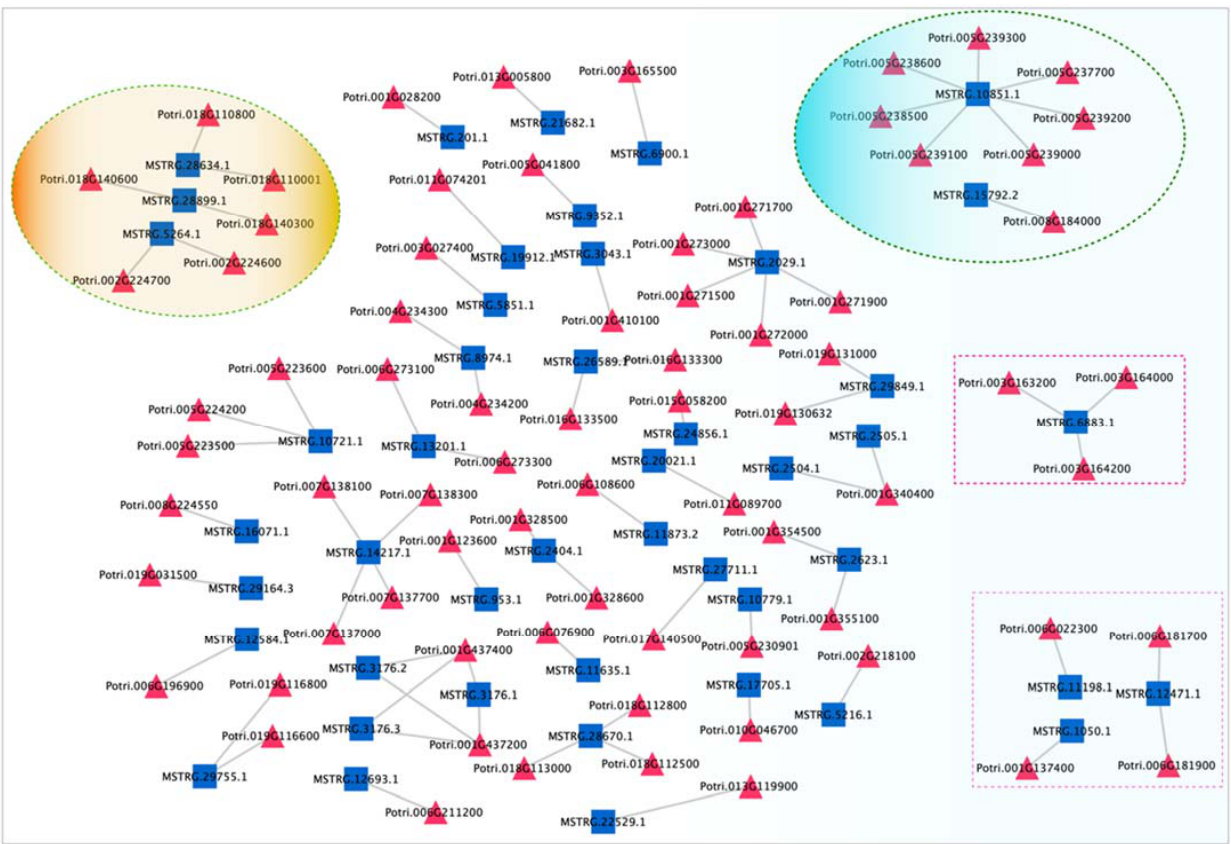
Figure 6. Regulatory networks of candidate lncRNAs with target mRNAs. Blue squares indicate lncRNAs, red triangles indicate the target mRNAs.